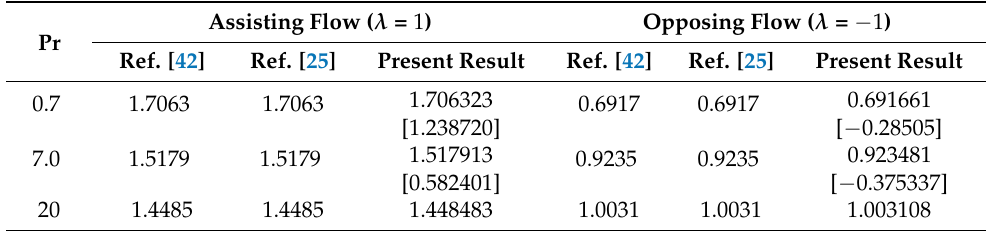
Table 3. Values of f (cid:48)(cid:48) ( 0 ) when ϕ 1 = ϕ 2 = 0, s = 0, Q = 0.